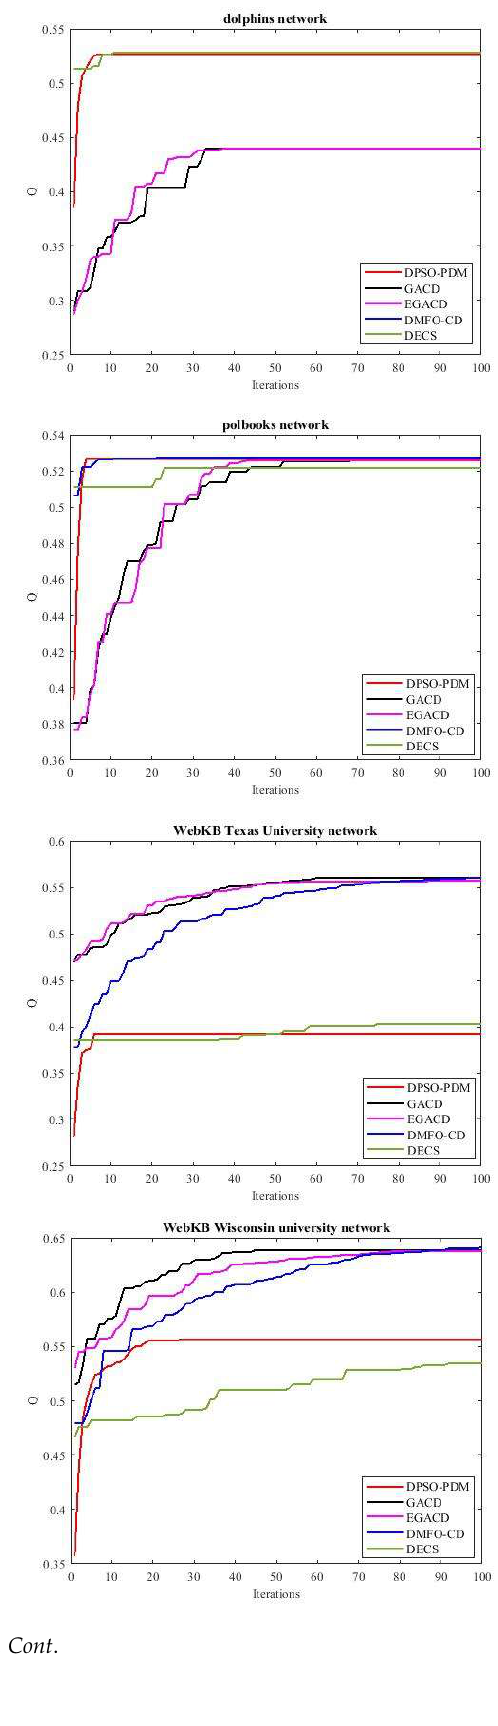
Figure 12. Convergence curves of the proposed DMFO-CD and comparative algorithms.